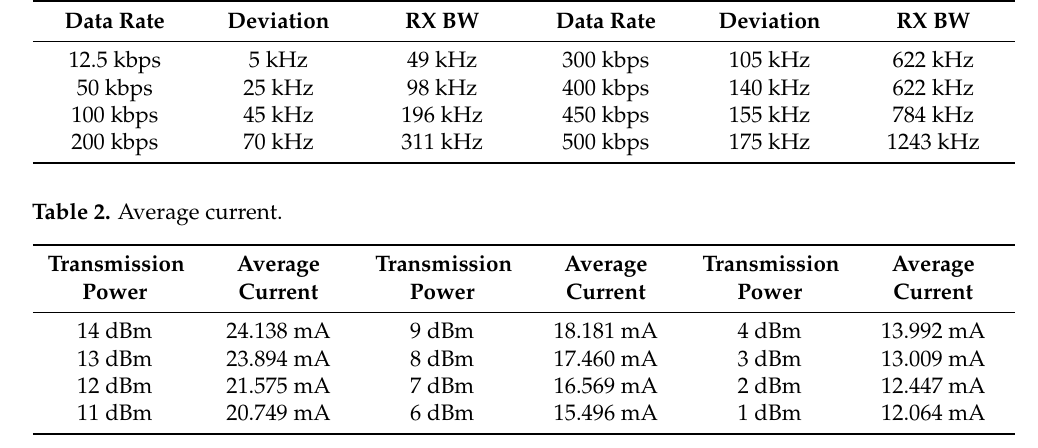
Table 1. Parameters of each data rate.